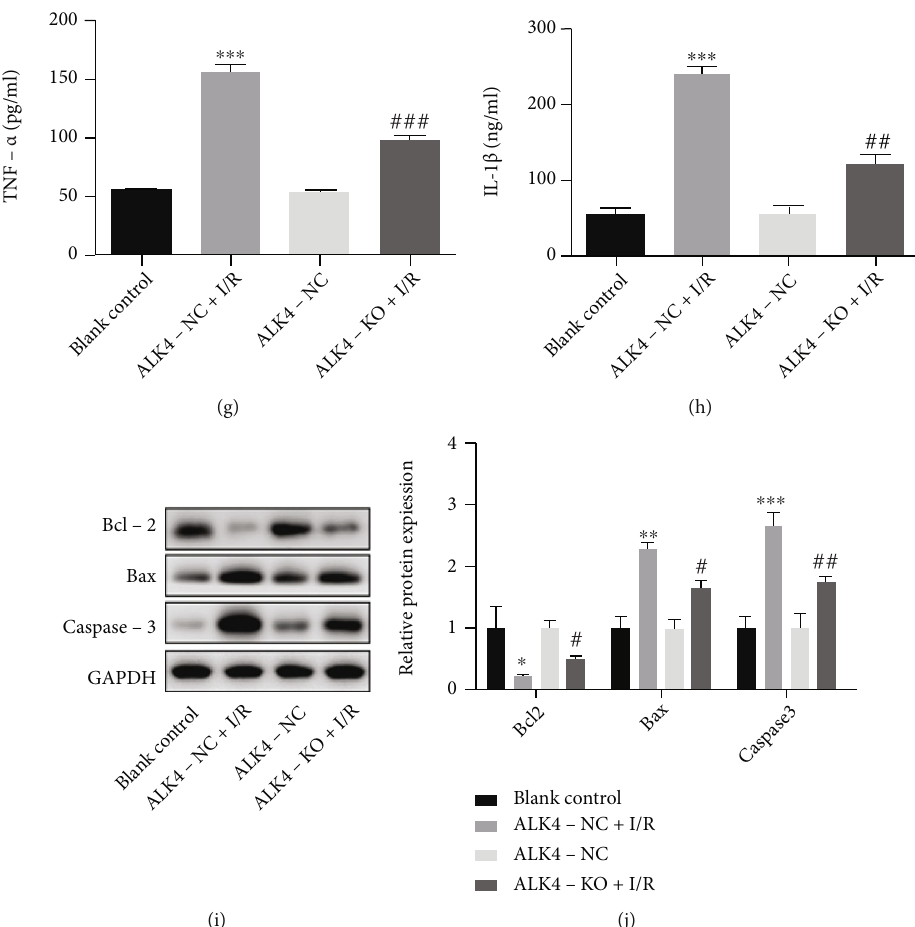
Figure 4: Expression of molecules related to TGF- β signaling pathway, antioxidants, in fl ammation-associated cytokines, and apoptosis- related molecules at 24 h after I/R injury in H9C2 cells. (a) The hydroxylamine method was used to detect SOD level. (b) The thiobarbituric acid method was used to detect MDA level. (c – e) Serum levels of CK, LDH, and AST were detected with corresponding ELISA kits. (f – h) In fl ammation-related factors (IL-1 β , TNF- α , and IL-6) were detected with corresponding ELISA kits. (i and j) Expression of BCL-2, Bax, and caspase-3 (Western blotting). Data are expressed as mean ± SD . ∗ P < 0 : 05 , ∗∗ P < 0 : 01 , and ∗∗∗ P < 0 : 001 , ALK4-NC+I/R group vs. ALK4-NC group. # P < 0 : 05 , ## P < 0 : 01 , and ### P < 0 : 001 , ALK4-KO+I/R group vs. ALK4-NC+I/R